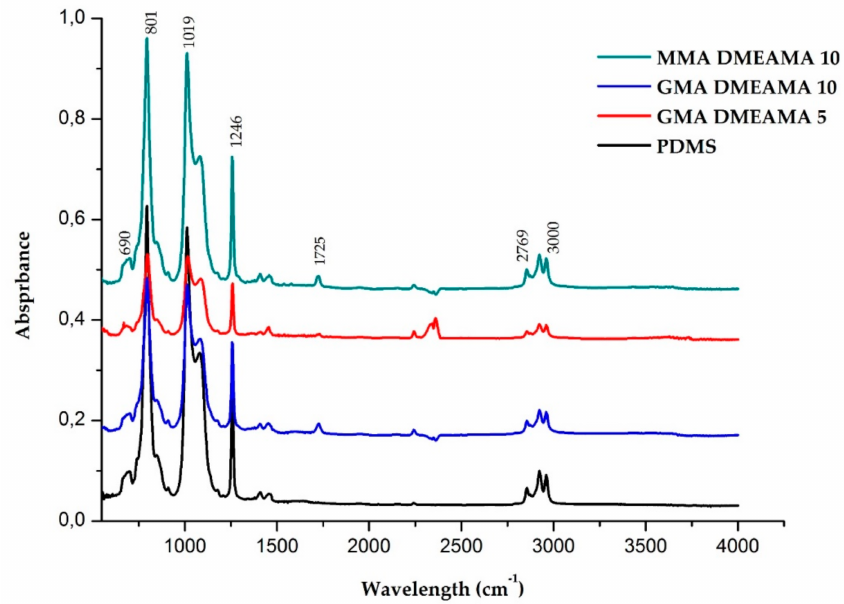
Figure 4. Fourier transform infrared spectra of bare and modified PDMS membranes on an active surface.